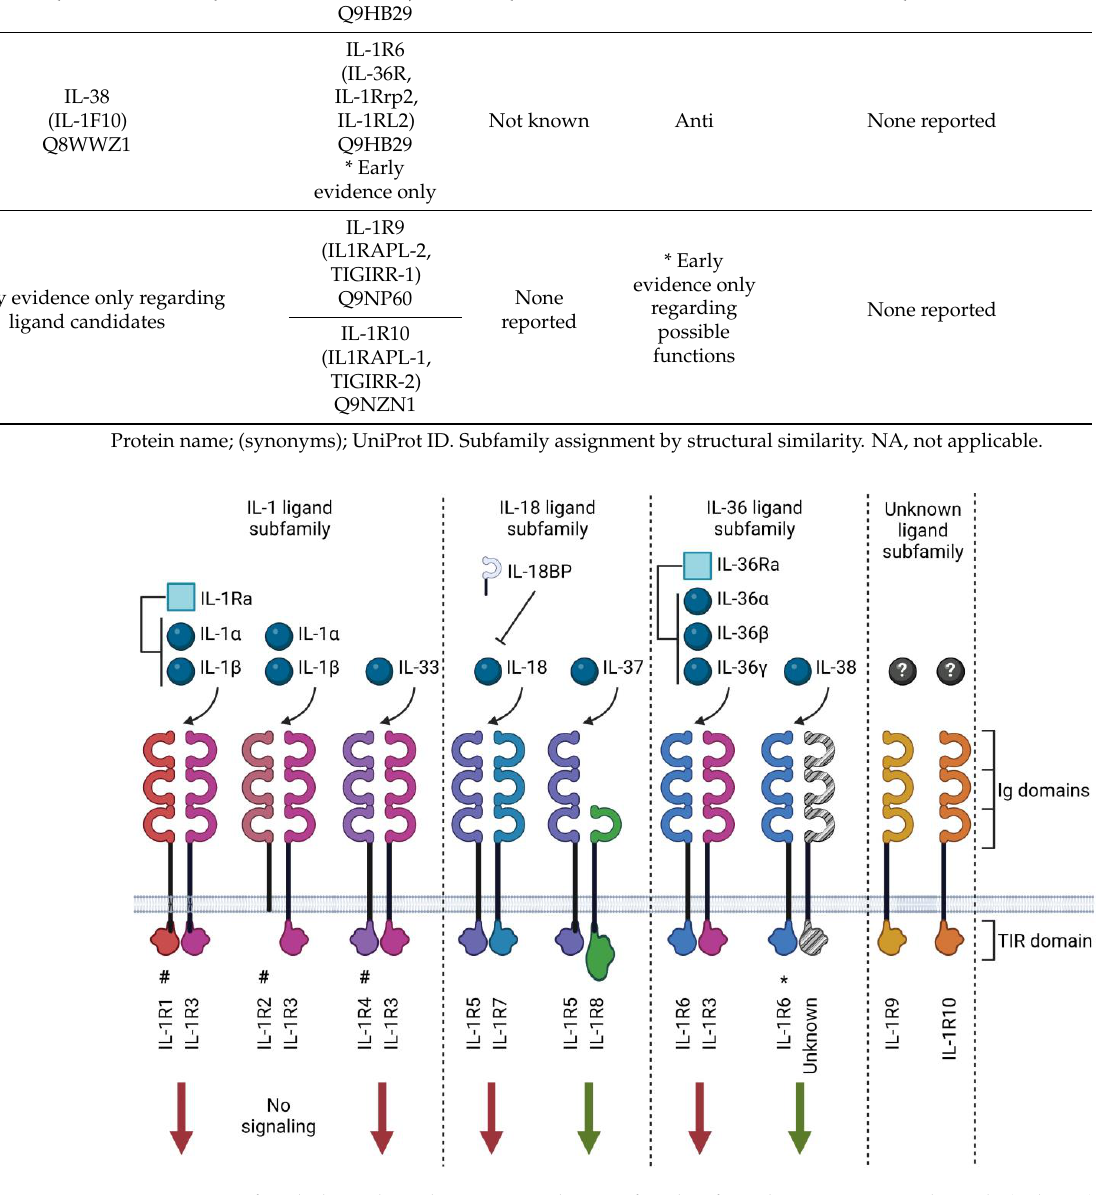
Figure 1. IL-1 family ligands and receptors. The IL-1 family of cytokines comprises ligands (spheres) and receptor antagonists (squares). This cytokine family utilizes ten receptors and one structurally related binding protein known as IL-18BP. The receptors may exert pro-inflammatory (red arrows) or anti-inflammatory (green arrows) signals. Most receptors contain three immunoglobulin (Ig) domains and a Toll-IL-1-receptor (TIR) domain, excluding IL-1R8, which only has one Ig domain. IL-1R2 lacks an intracellular TIR domain, and IL-1R8 has a TIR domain with two amino acid substitutions. Receptors act as scavengers in soluble form (#); receptors for which ligand binding is preliminary (*); orphan receptors with no well-established ligands (?). Created with